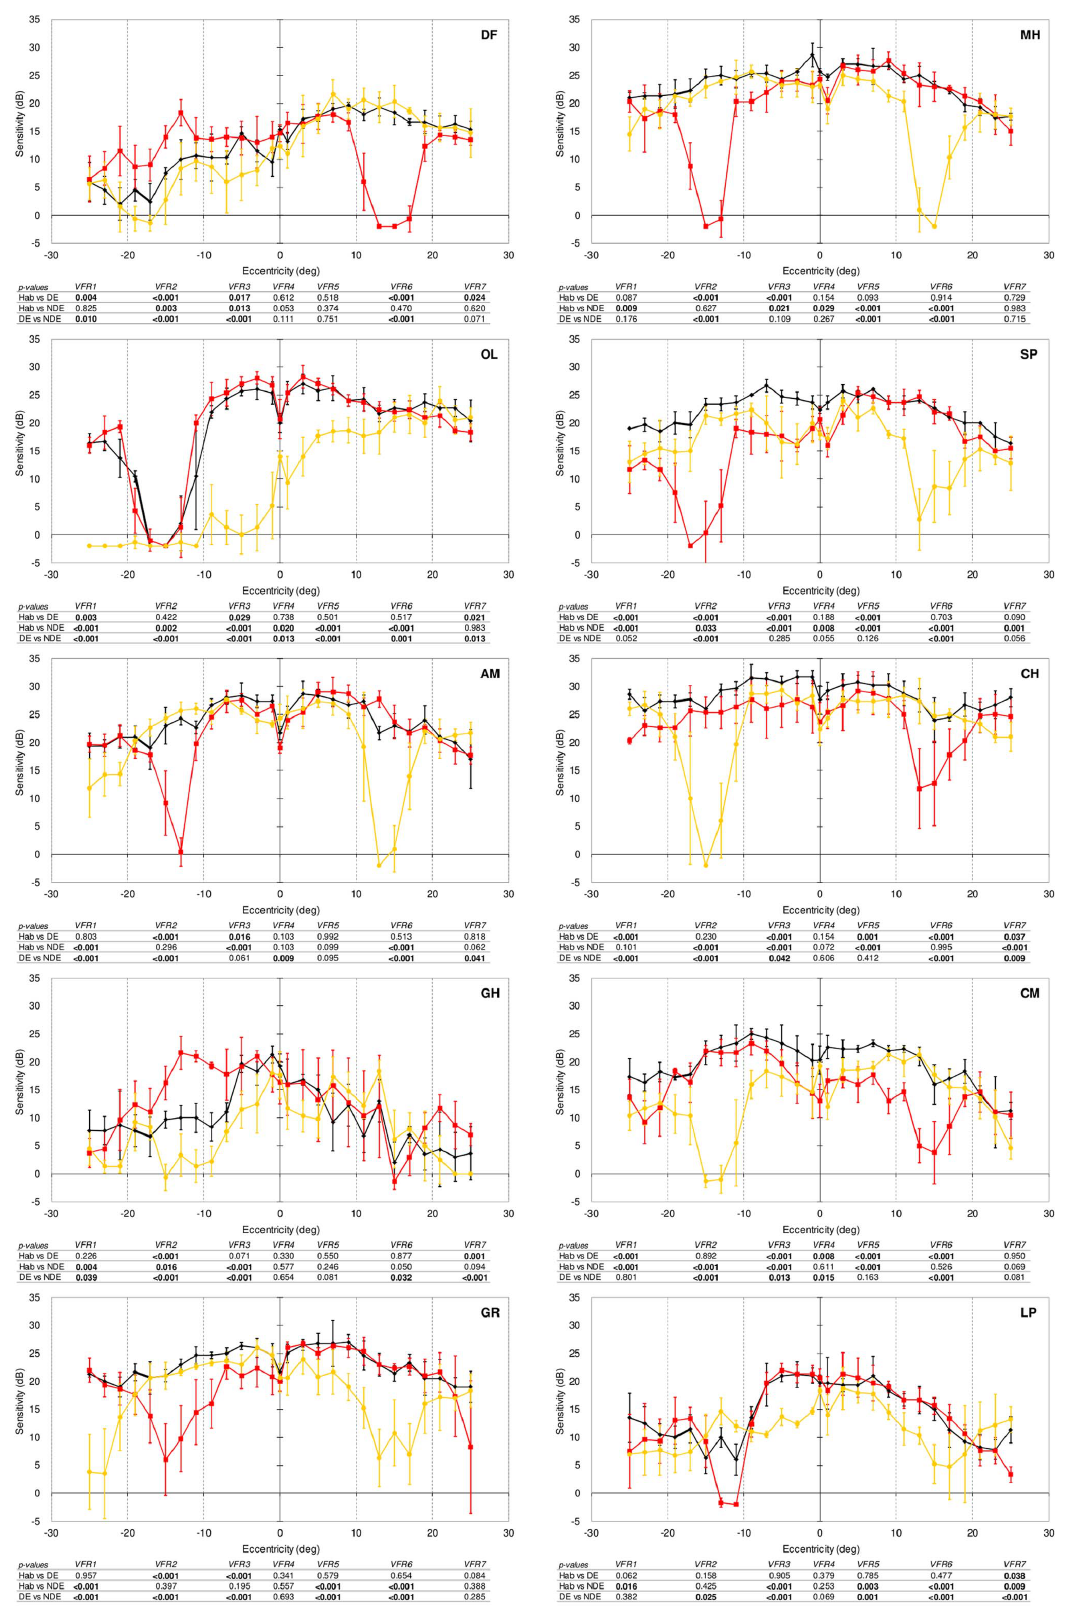
Figure 4. Similar to Figure 3 except that results are shown for individuals with strabismic amblyopia.